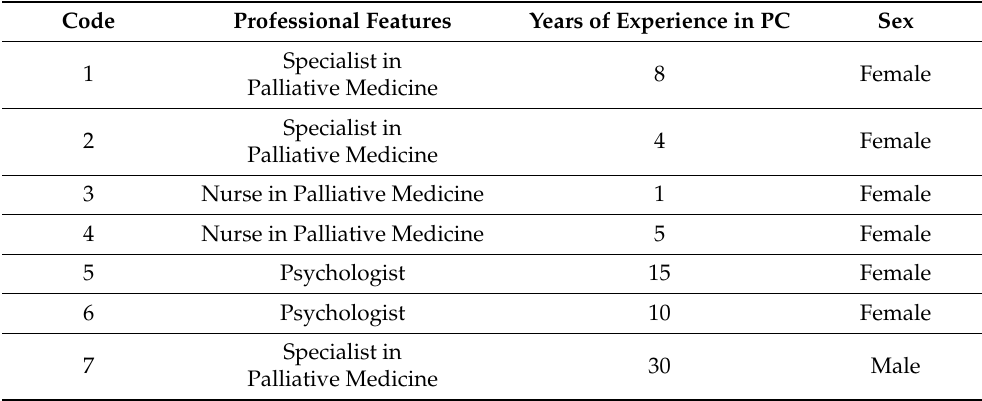
Table 2. Characteristics of the FG